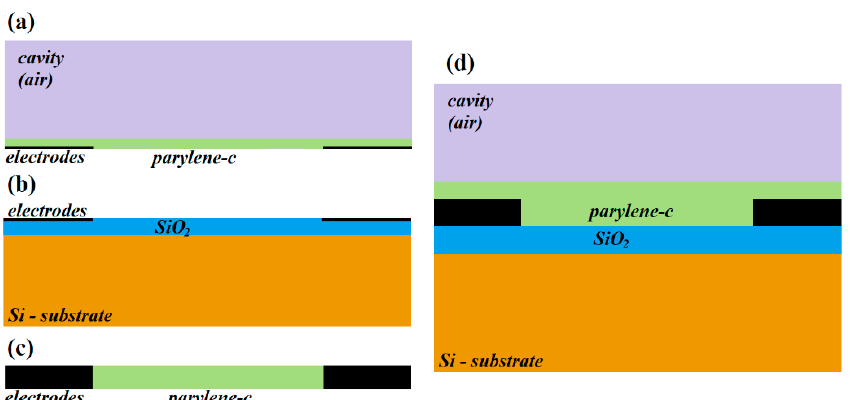
Figure 3. Schematic representation of the set of structures used for simulation routines. Structures shown in ( a ), ( b ), ( c ) and ( d ) are used for simulating the capacitance components C 1 , C 2 , C 3 as well as C T , respectively.